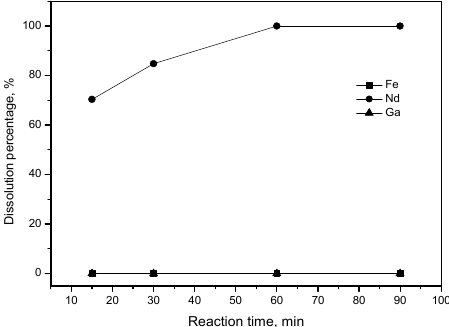
Figure 5. Effect of time on the leaching of the oxide mixtures by 1.0 M HCl in EG. Operation condi- tions: pulp density = 50 g/L, T = 25 °C, stirring speed = 400 rpm.